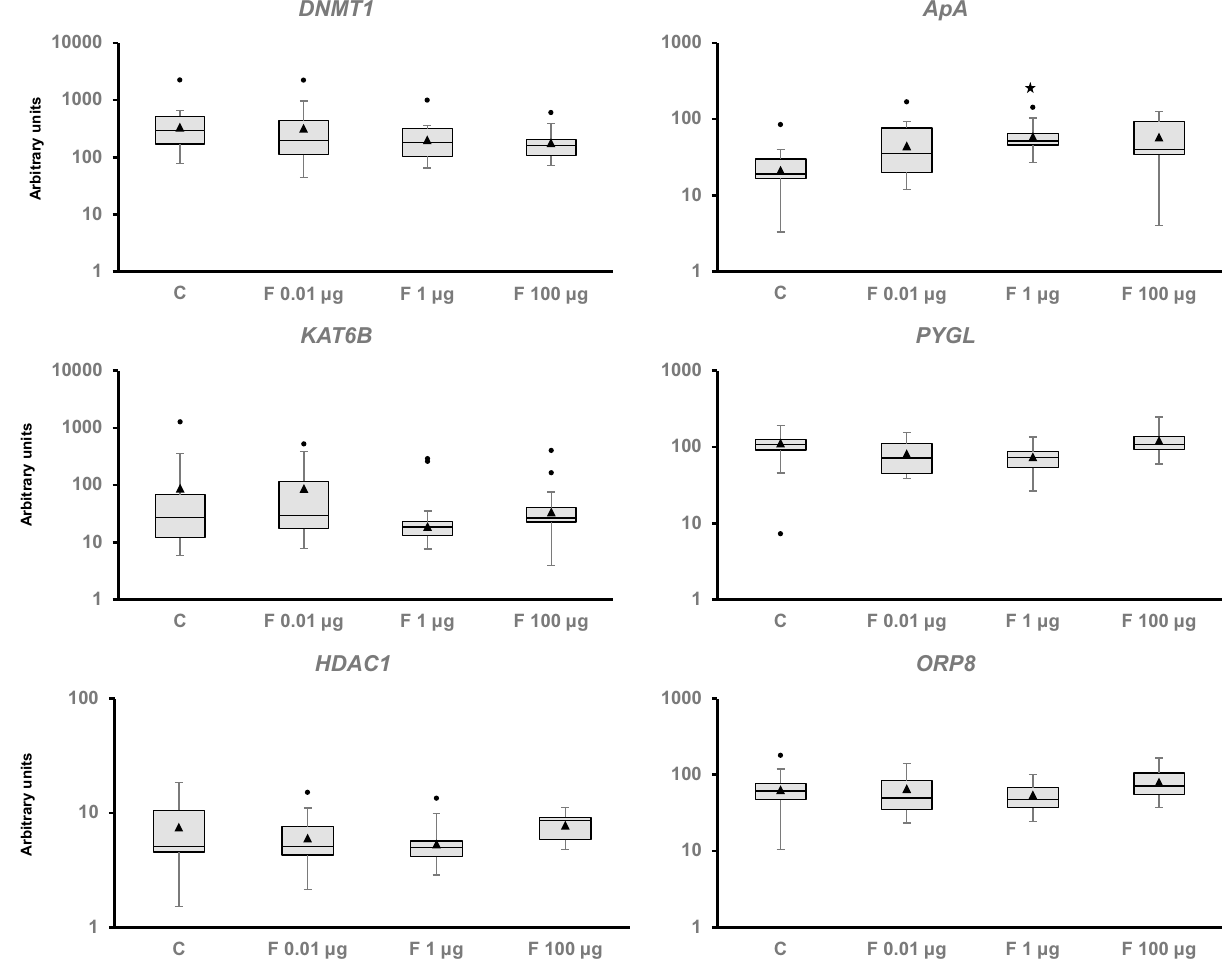
Figure 6. Transcriptional activity of genes related to epigenetic modulation ( DNA methylase I [ DNMT1 ], Lysine Acetyltransferase 6B [ KAT6B ], and histone deacetylase 1 [ Hda1 ]), immunity ( aplysianin-A [ ApA ]), and energy metabolism ( glycogen phosphorylase L [ PYGL ] and oxysterol binding protein like 8 [ OSBPL8 ]) in Physella acuta adults after in vivo exposure to Fenoxycarb for seven days at 19 °C. Transcriptional activity was quantified by RT-PCR using ribosomal protein L10 ( rpL10 ), actin ( Act ), 6-phosphofructo-2-kinase/fructose-2,6-biphosphatase 2 ( PFKFB2 ), and glyceraldehyde-3-phosphate dehydrogenase ( GAPDH ) as reference genes. The comparison was performed with the solvent-exposed controls. Whisker boxes are shown. Each box corresponds to 12 individuals. The median is indicated by the horizontal line within the box, and the 25th and 75th percentiles are indicated by the boundaries of the box. The highest and lowest results are represented by the whiskers. The small triangle inside the box denotes the mean, and the outliers are shown (circles). Significant difference relative to the controls (asterisk) is indicated (p <